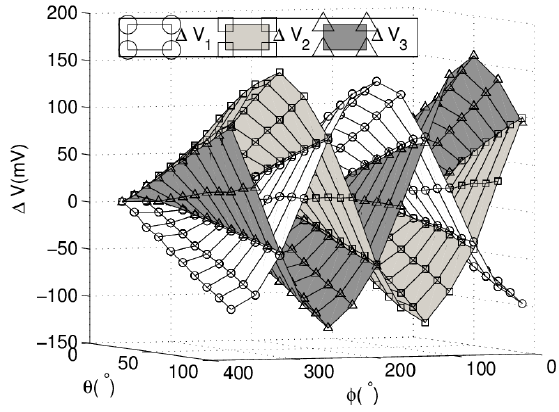
Figure 6. Experimental results on sample points.